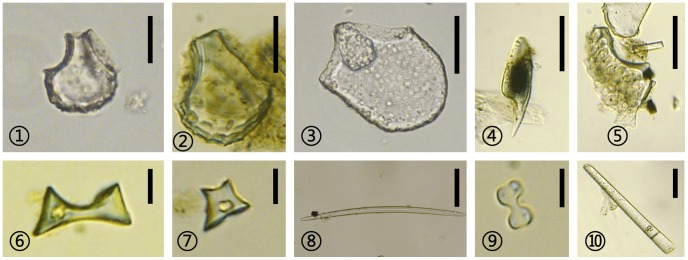
Phytoliths from the Jiangli site.
,
Oryza-type bulliform;  Reed-type bulliform;  Acicular hair cell;  Double-peaked Oryza-type;  Bamboo-saddle;  Short-saddle;  Sponge spicule;  Bilobate;  Elongate psilate long cells. Scales: ,, 20 µm; ,, 40 µm; , , , 50 µm; ,,, 10 µm.